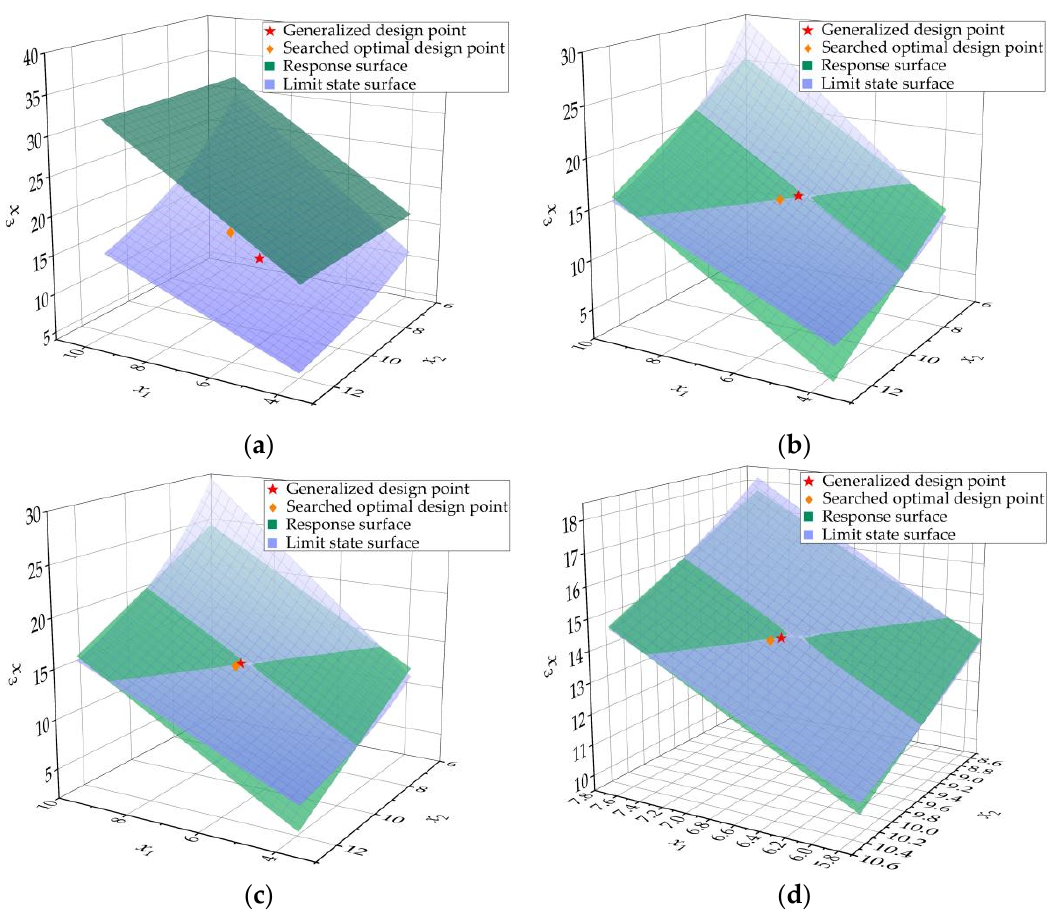
Figure 7. Fitting process of the response surface in each step: ( a ) step 1, ( b ) step 2, ( c ) step 3, ( d ) step 4.